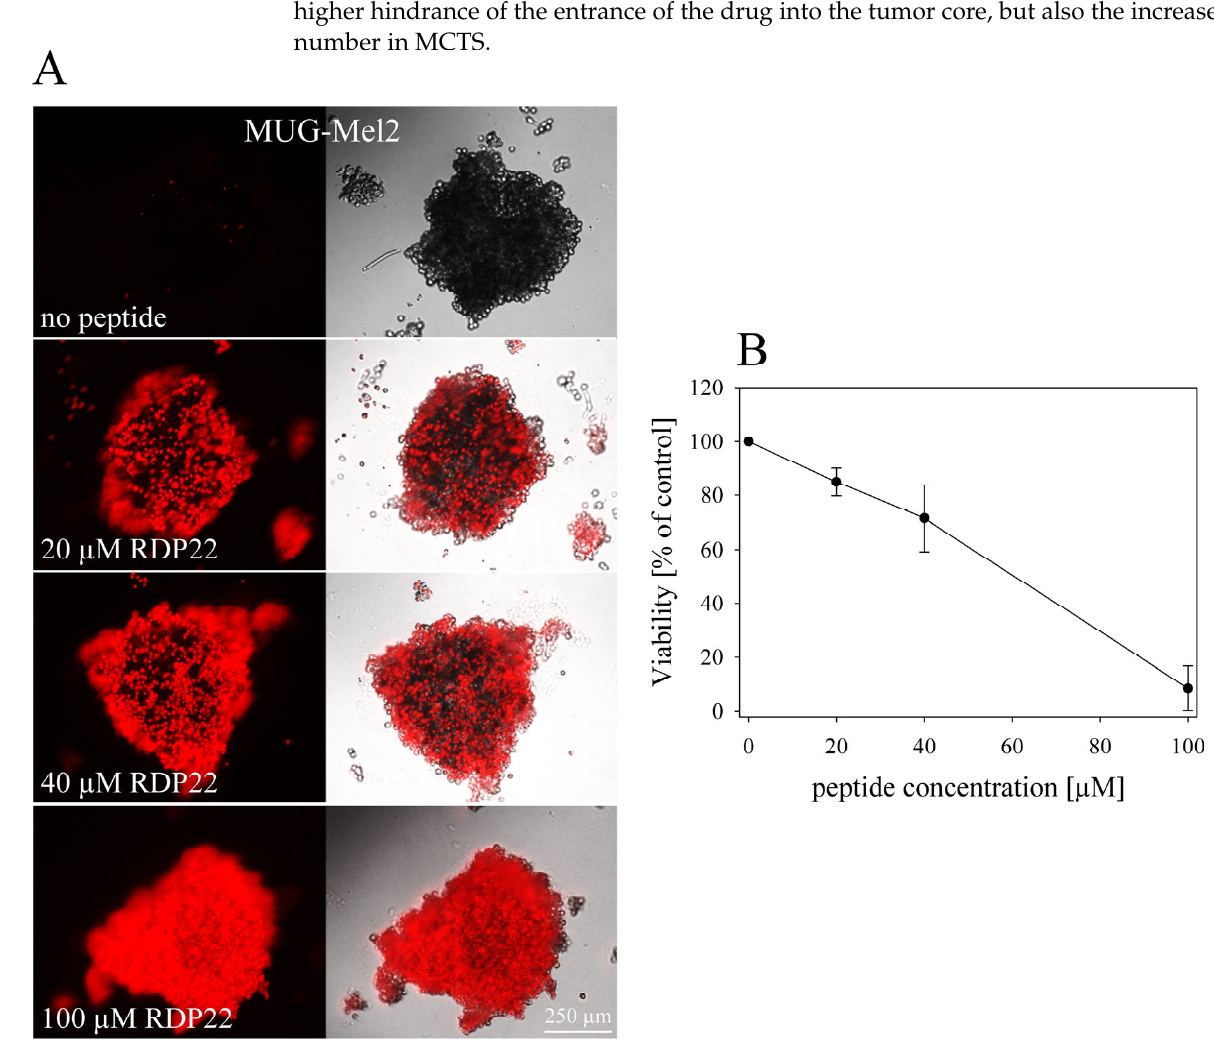
Figure 6. ( A ): Cytotoxic activity of antitumor peptide RDP22 on MUG ‐ Mel2 spheroids. Spheroids were formed by incubation of cells for 72 h in a hanging drop culture. Cytotoxicity of 0 – 100 μ M of respective peptides on different types of spheroids was determined upon 24 h of peptide incubation via PI ‐ uptake (red). Pictures are representative of a series of several experiments and were taken in the middle plane area of the spheroids, to visualize potential penetration capability of the peptides. ( B ): 3D cell viability of MUG ‐ Mel2 spheroids in dependence of RDP22 upon 48 h of peptide incuba ‐ tion from 0 to 100 μ M. Spheroids were formed by incubation of cells for 5 days in Corning ® 96 ‐ well Spheroid Microplates with a round clear bottom (Ultra ‐ Low Attachment surface). Untreated MUG ‐ Mel2 spheroids were used as negative control, representing 100% of viable cells. The 3D assay rea ‐ gent measures ATP (adenosine triphosphate) as an indicator of viability. Data points represent mean values with respective SD of at least three independent experiments.